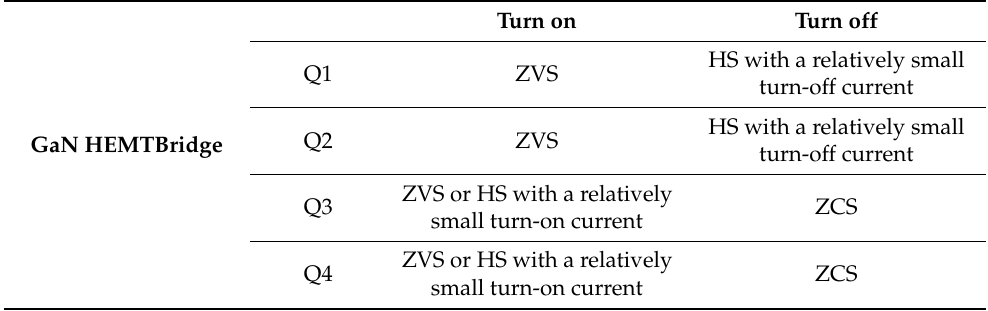
GaN HEMT Table 1. Switching states of the proposed topology.